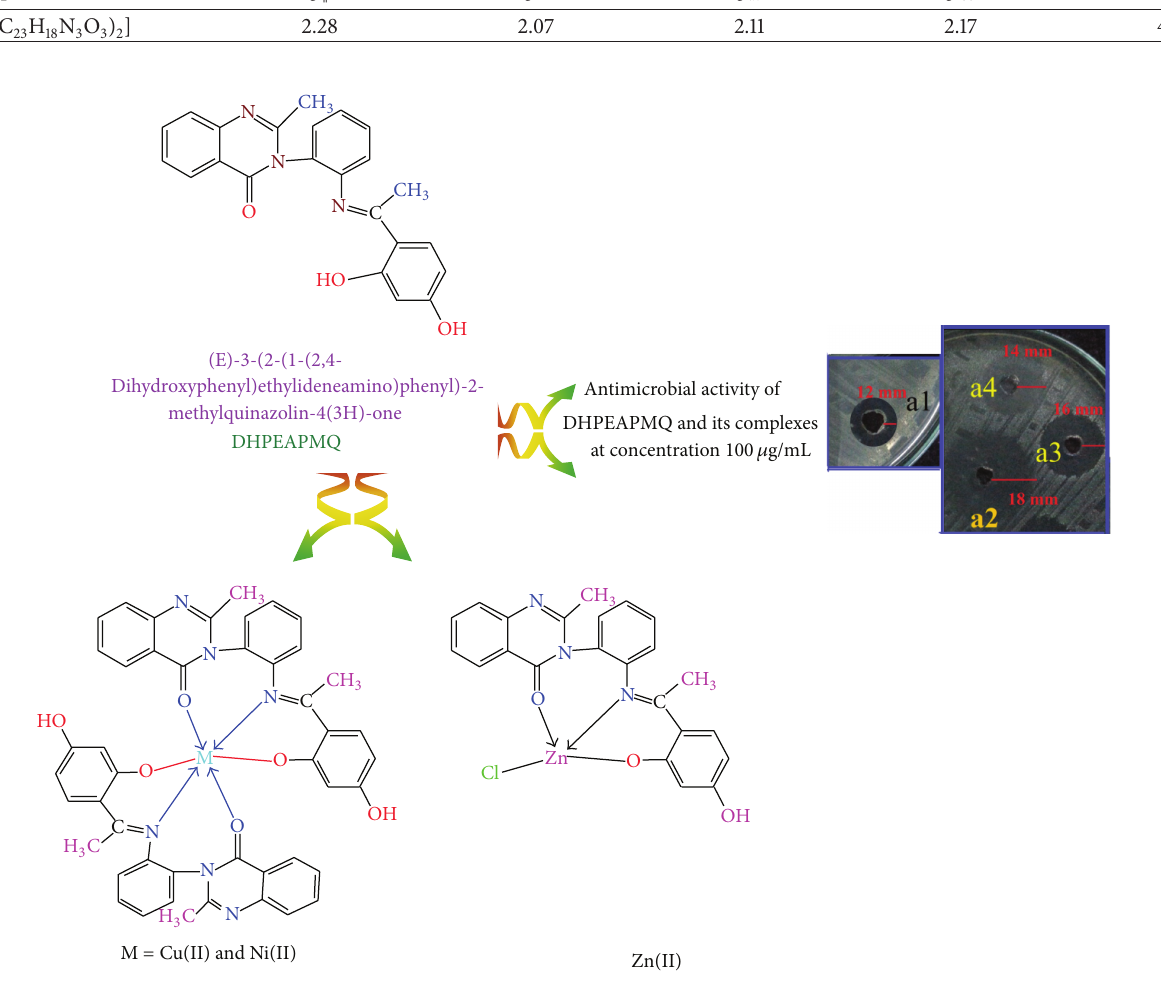
Figure 3: Antimicrobial activity of Schiff base (DHPEAPMQ) and its complexes against MRSA [a1: Schiff base (DHPEAPMQ), a2: Cu(II), a3: Ni(II), and a4: Zn(II) complex].